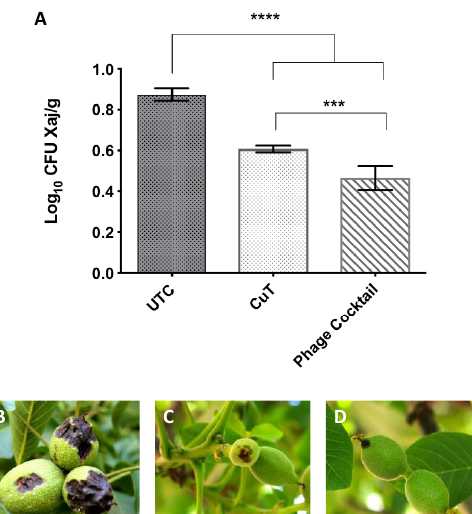
UTC: Untreated control, CuT: Conventional treatment based on commercial copper compounds. Averages in the same column with the same letter do not differ statistically ( p < 0.05). The dates cited in the table indicate the times of sampling from the treated trees.